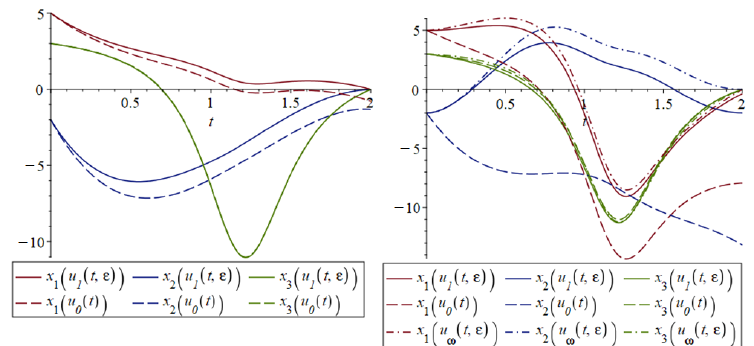
Figure 1. ( left ) Trajectories of the closed-loop systems for ε = 0.1. ( right ) Trajectories of the closed- loop systems for ε = 1.